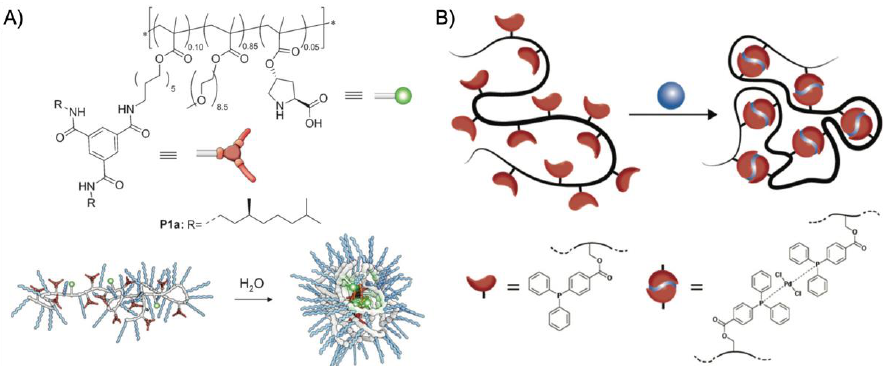
Figure 4. Example for single chain polymer nanoparticles (SCPN) catalysis. ( A ) SCPN with L -proline for the enantioselective aldol reaction of cyclohexanone and p -nitrobenzaldehyde. ( B ) Selective point folding of SCPNs promoted by triphenylphospane coordination with dichloro(1,5-cyclooctadiene)palladium. ( A ) reproduced with permission of [58]. Copyright 2013 Wiley-VCH. ( B ) reproduced with permission of [63]. Copyright 2015 Royal Society of Chemistry.